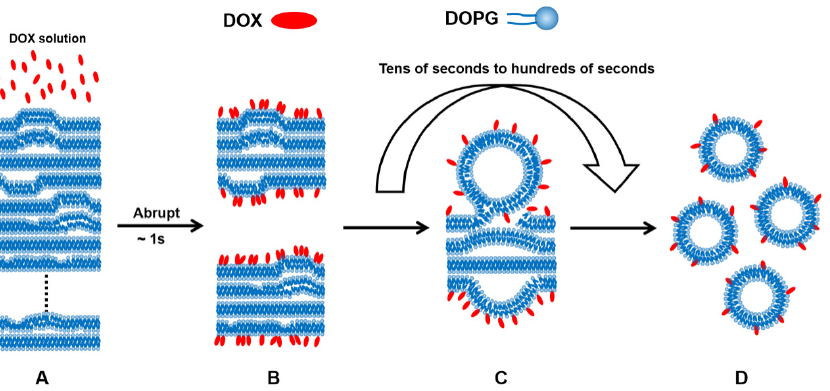
Figure 14. Kinetic model of the vesicle formation from DOPG multiple layers through hydration methods. Reproduced with permission [47]. Copyright 2022 Royal Society of Chemistry.